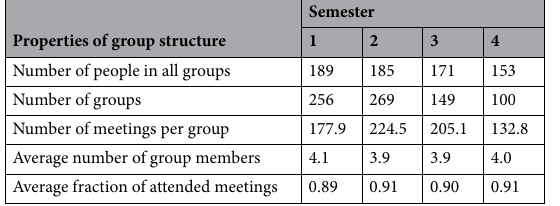
Table 1. Properties of groups. General statistics on the groups detected through hierarchical clustering for each of the available semesters in